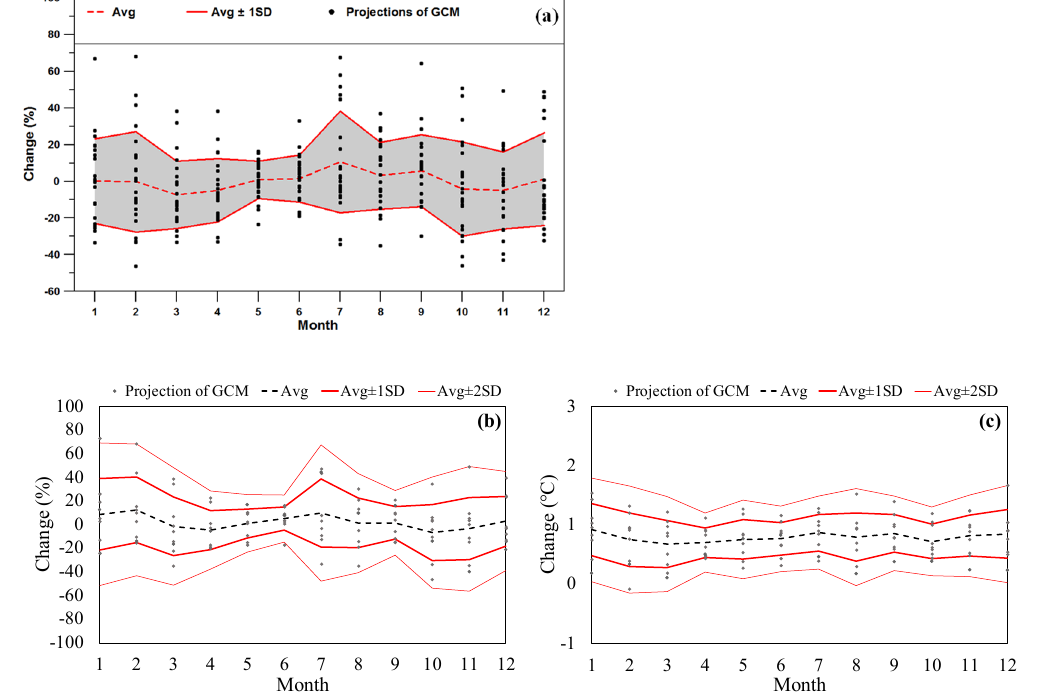
Figure 4. ( a ) Monthly projections by 24 GCMs of rainfall. Monthly projections by nine GCMs of ( b ) rainfall, and ( c ) air temperature at Ziqiang Bridge in the A1B climate scenario.